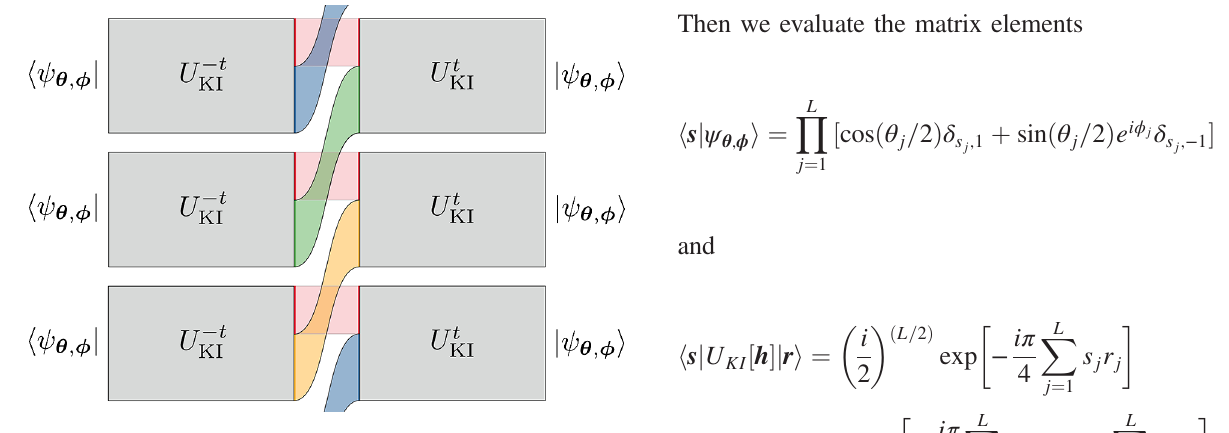
t ÞÞ 3 (cid:2) according to A ð